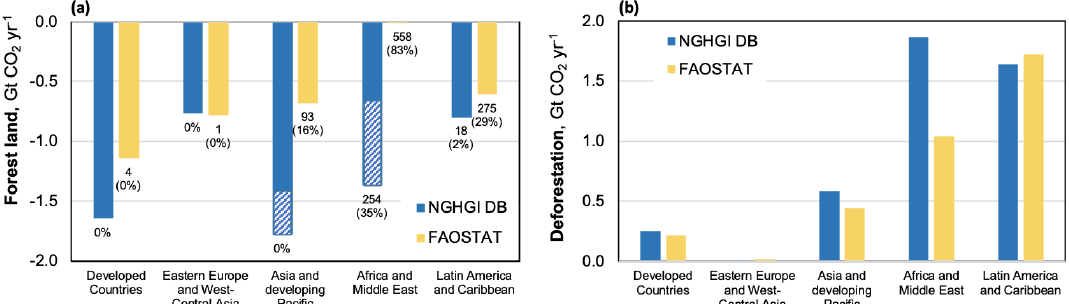
Figure 6. CO 2 fluxes (average 2000–2020) in the five macro-regions from our NGHGI DB and FAOSTAT, for forest land (a) and defor- estation ( b , net deforestation in FAOSTAT). The numbers next to each column in panel (a) indicate the areas (in Mha, and % relative to the respective regional forest area) where no or zero carbon flux is estimated for FL or for FL–FL. In panel (a) , the dashed blue areas indicate the carbon fluxes that we consider implausible in the NGHG DB (see